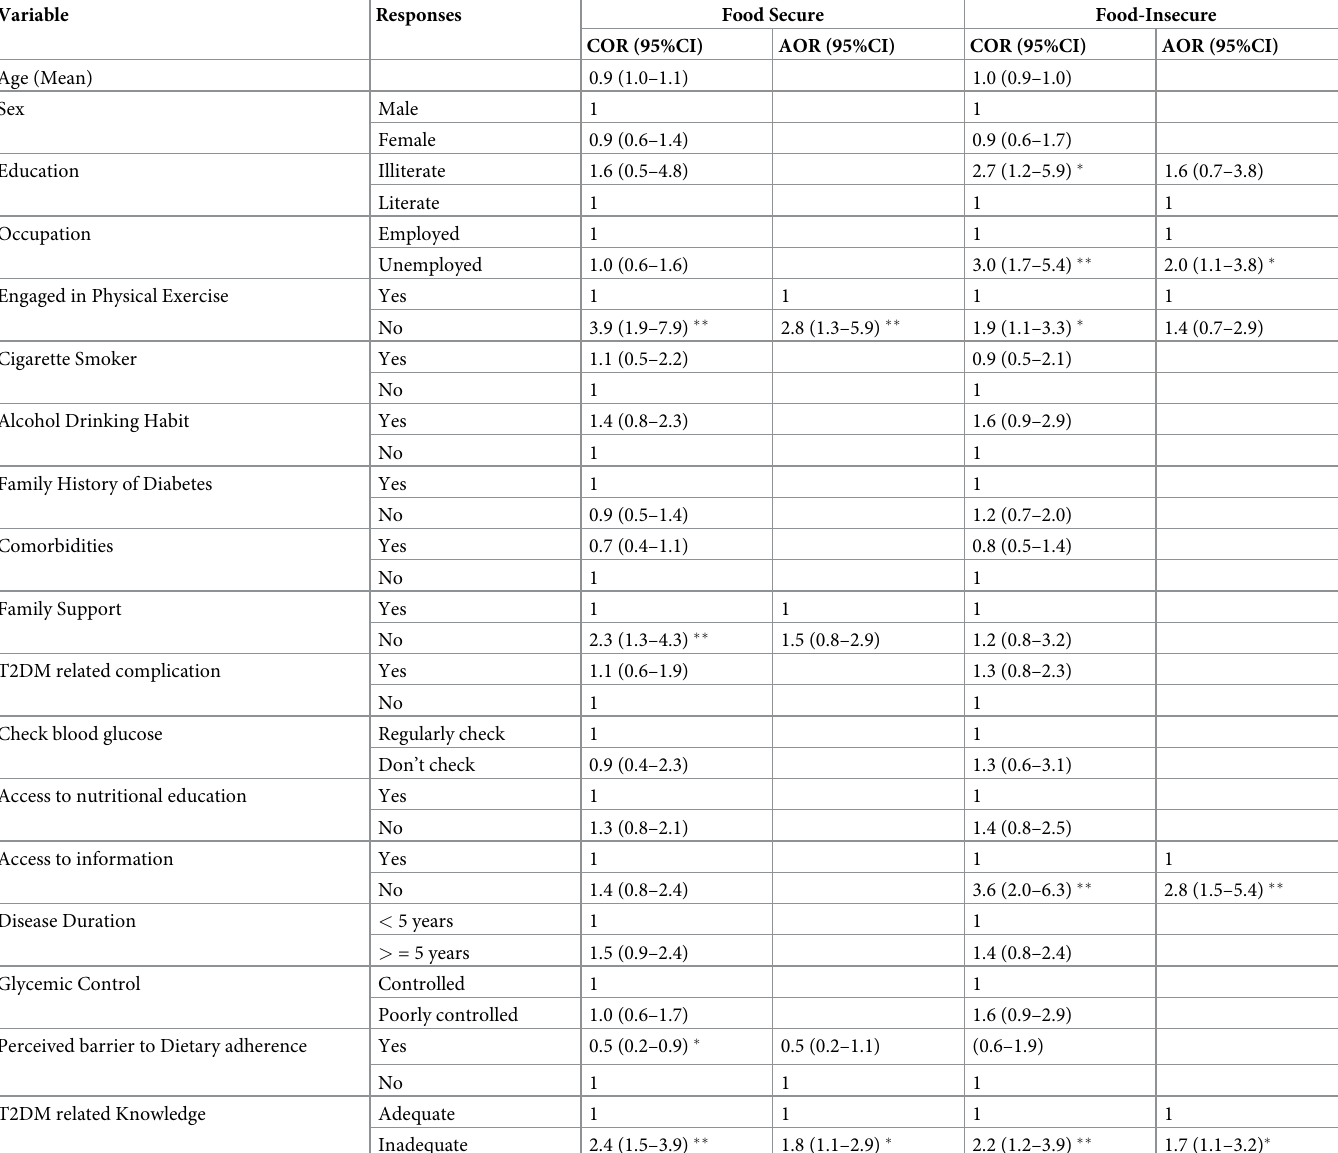
Table 5. Stratum-specific multiple regression analysis of dietary nonadherence predictors based on the food security status of patients with T2DM at selected public hospitals in Addis Ababa, 2019.